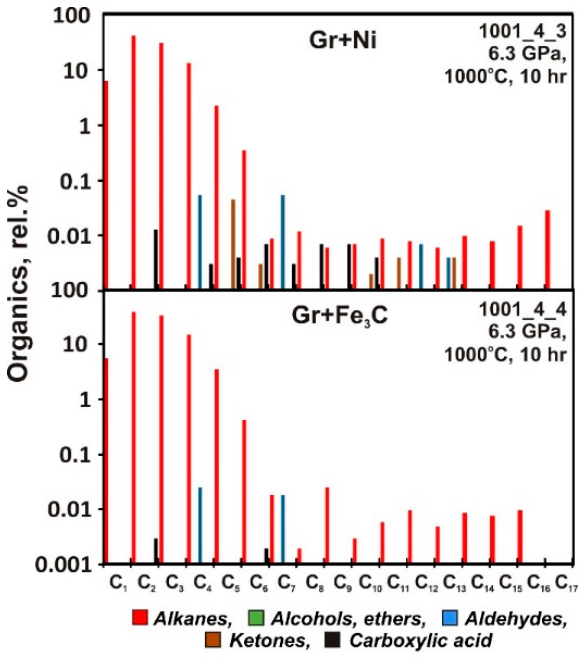
Figure 4. Speciation of minor organic components in quenched fluids obtained in 1000 ◦ C runs in the presence of Ni and Fe 3 C.